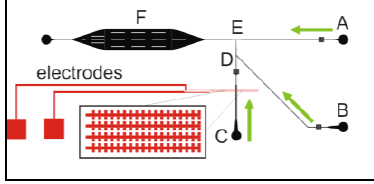
FIGURE 1: Device architecture generating microdroplets with mean diameter of 80